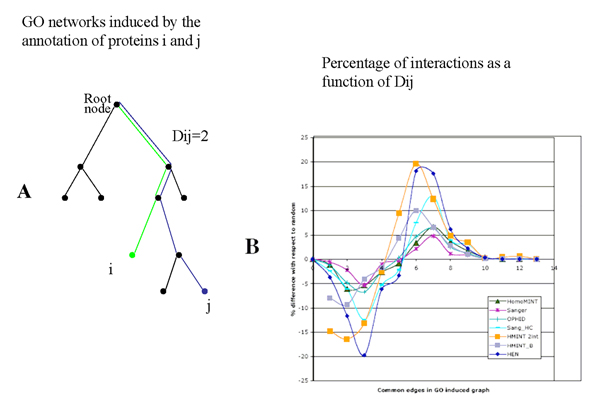
Degree of common annotation in interacting protein pairs in experimental and inferred networks. A) Schematic representation of the algorithm used to evaluate the relatedness of gene ontology annotation. The Gene Ontology graph induced by protein 'i ' is in green, while the one induced by protein 'j' is in blue. Dij is the number of edges that the two induced graphs have in common. B) For any given network we have derived a 'scrambled network' containing the same protein nodes linked by the same number of edges with their connections rearranged at random. For each interacting protein pair, in which both proteins have a GO annotation, we have then calculated Dij. Finally we have plotted, as a function of Dij, the difference between the percentage of nodes having a specific Dij in the inferred and in the scrambled network.